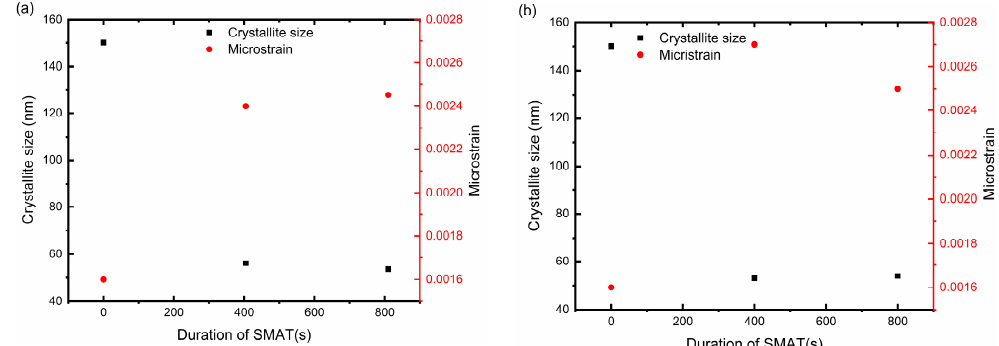
Figure 7. Zoomed images of the XRD patterns of Figure 6. Figure 7 . Zoomed images of the XRD patterns of Figure 6.